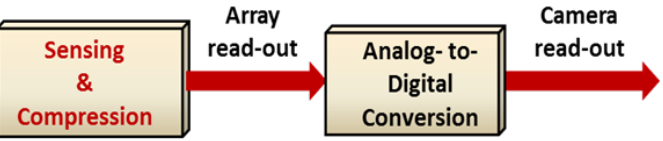
Figure 5. Block diagram of a CS encoding